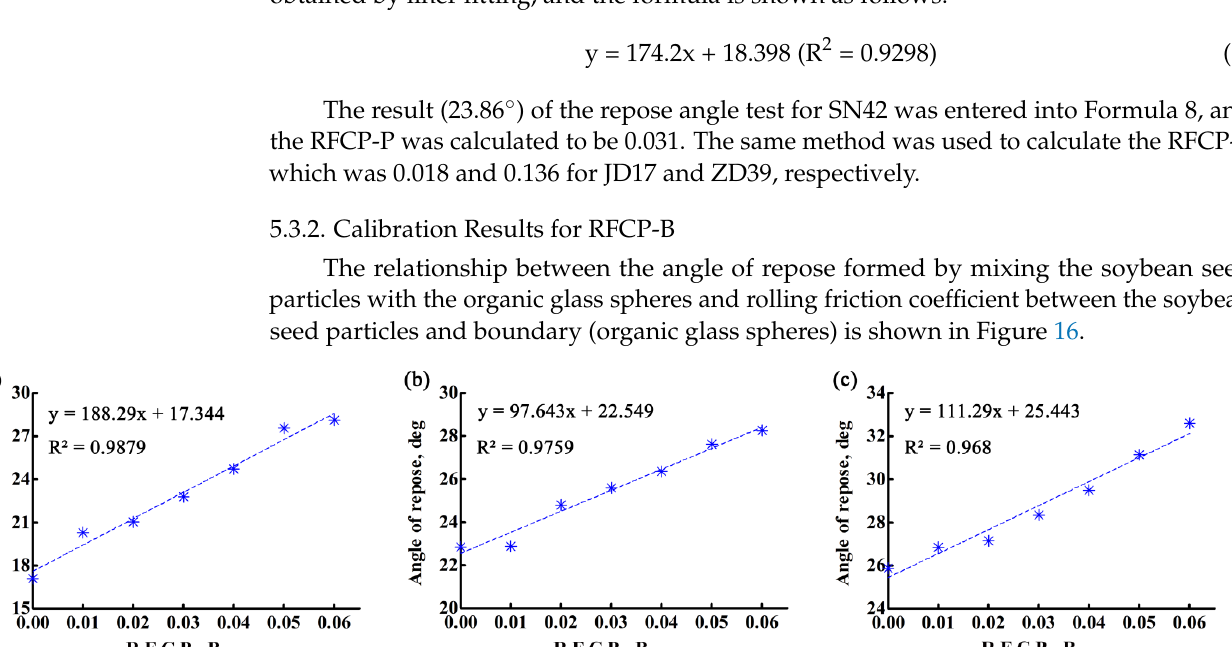
Figure 15. The relationship between the angle of repose and the RFCP-P for ( a ) SN42, ( b ) JD17, and ( c ) ZD39. ( c ) ZD39.